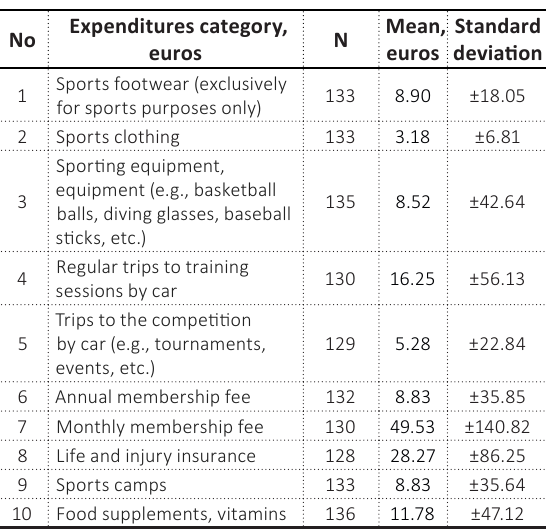
Table 3. A nnual (nine months) parental expenses for children’s sports activities